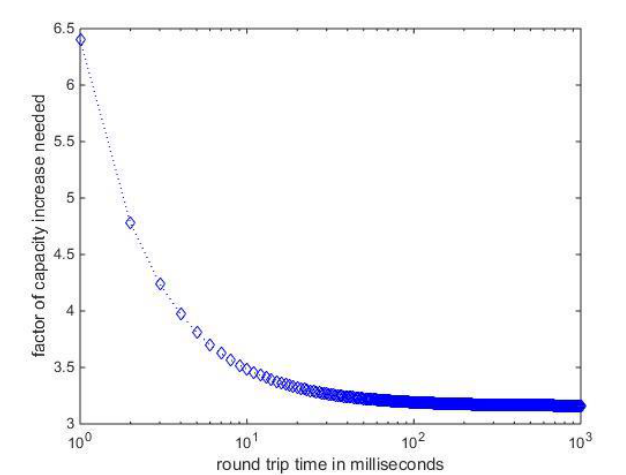
Figure 6. Capacity increase factor for C = 512kbps and Q=10000